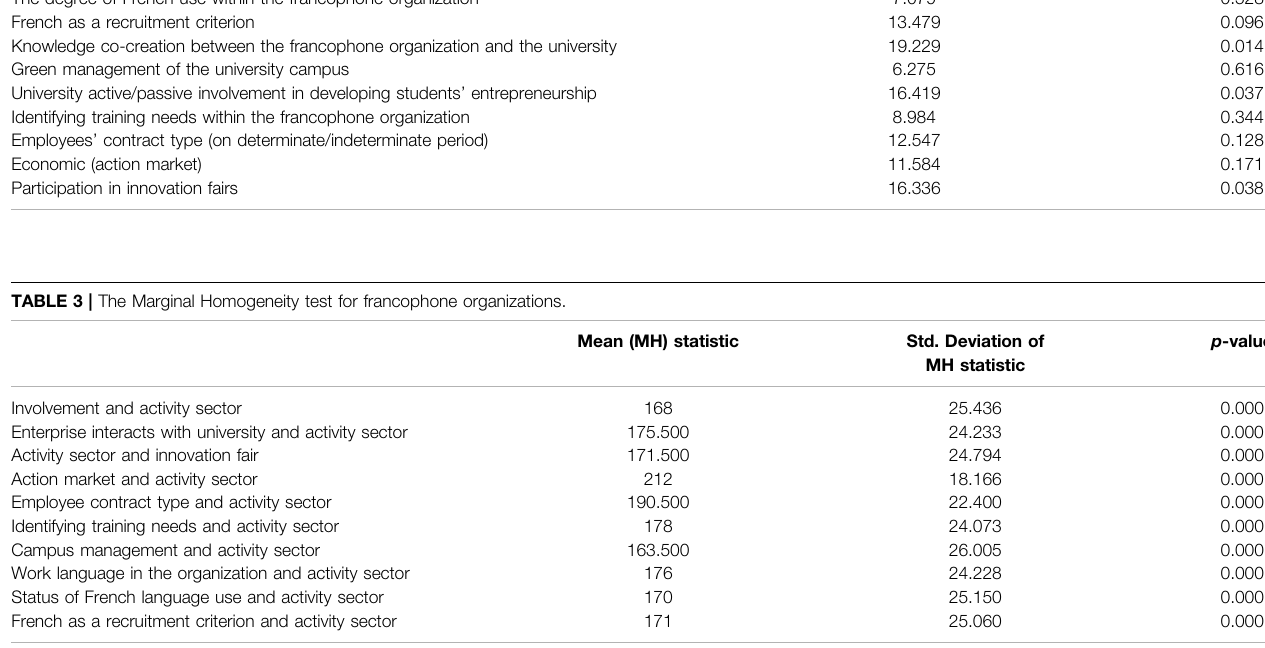
TABLE 2 | The Kurskal-Wallis test result for francophone organizations. Variable/Dimension